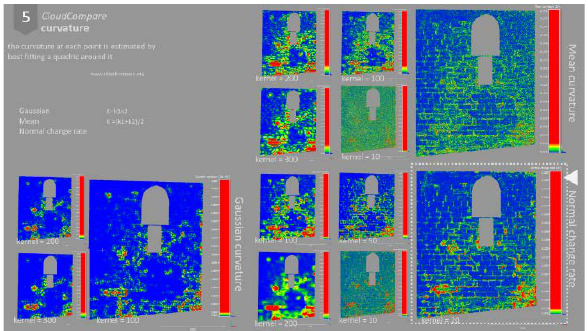
Figure 12. Curvature maps. Tests on the change in kernel values in the three calculable curvatures.